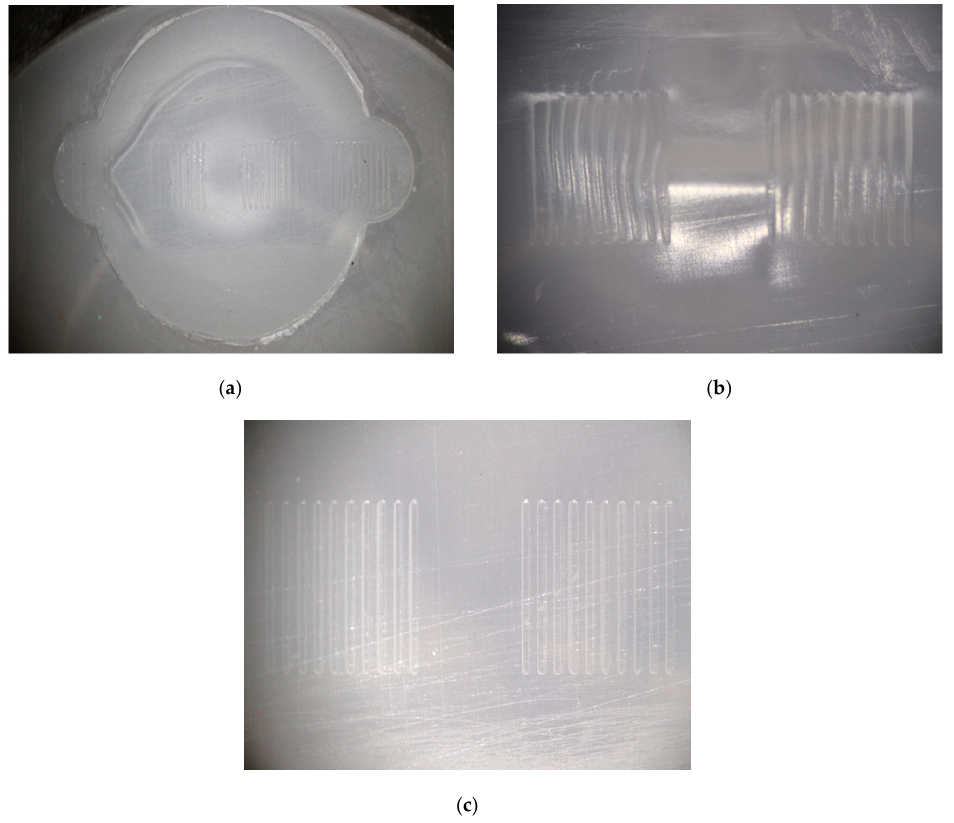
Figure 7. Optical micrographs of ( a ) microfeature molded surface, ( b ) Groups B and C molded with initial processing conditions that produced sink marks, and ( c ) Groups B and C molded with optimized process conditions, which eliminated the sink marks.